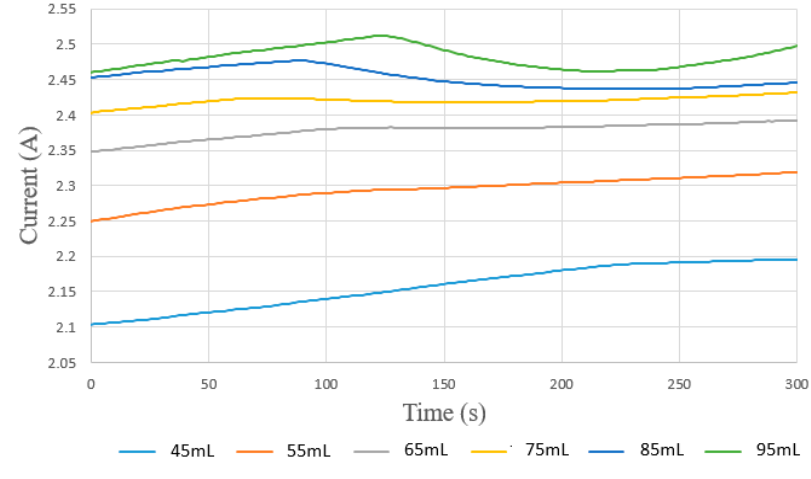
Figure 7. Performance curves of different flow rates.